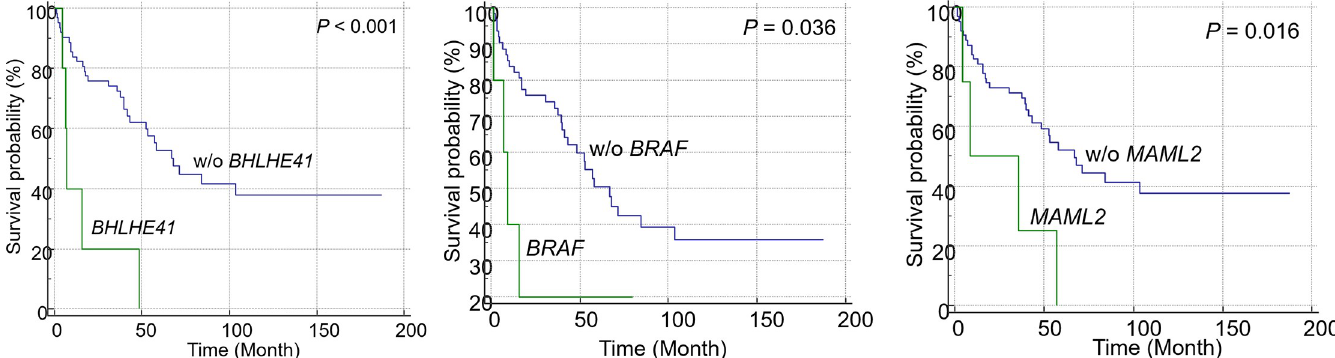
Fig 5. Kaplan-Meier analysis of overall survival in patients with mutations in the driver genes. BHLHE41 ( P < 0.001) and MAML2 ( P = 0.016) mutations were significantly correlated with poor prognosis in the log-rank test, while BRAF mutations were significantly correlated with poor prognosis only in the Breslow test.